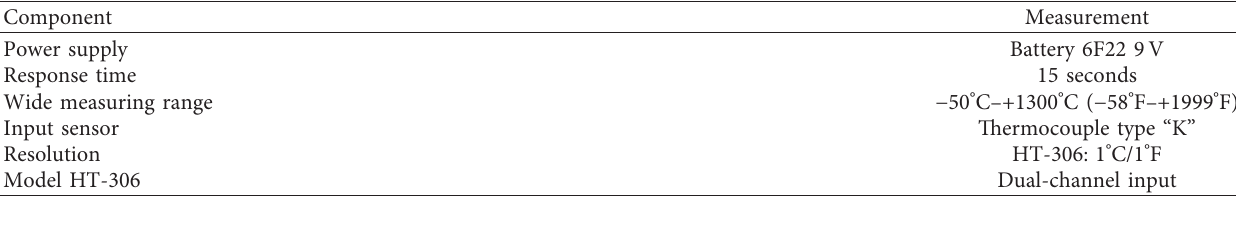
Table 1: Specifications of digital thermometer